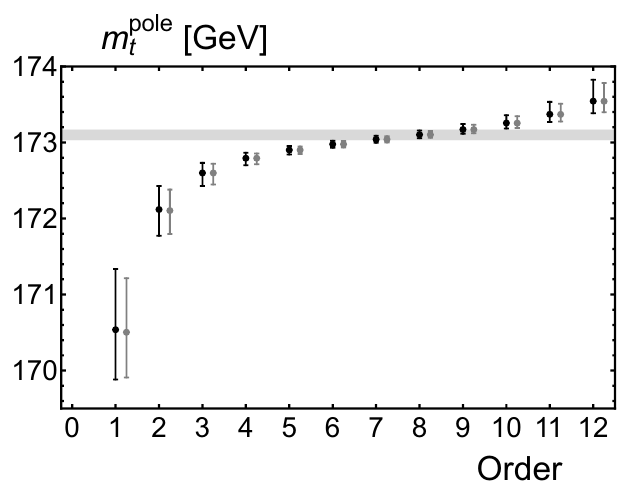
Figure 5 . Top quark pole mass as a function of order obtained from the MSR mass m MSR (black) and m t = m t ( m t ) = 163 GeV (gray) for massless bottom and charm quarks. The central dots refer to the renormalization scale (cid:22) = m t for the strong coupling. The error bars arise from renormalization scale variation m t = 2 (cid:20) (cid:22) (cid:20) 2 m t . The gray horizontal band represents the region m pole = 173 : 10 (cid:6) 0 : 07, which indicates the top quark pole mass and its scale uncertainty obtained t from m MSR ( m t ) at the 8th t